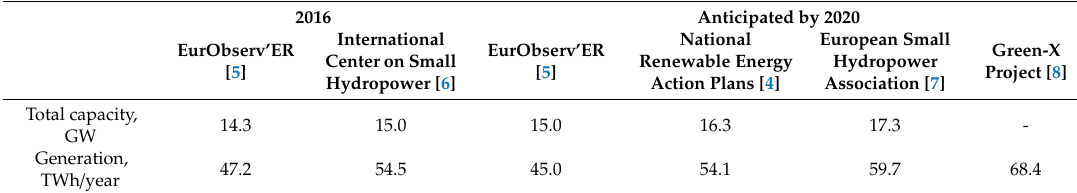
Table 1. Small hydropower current state and previsions up to 2020 in the EU-28.